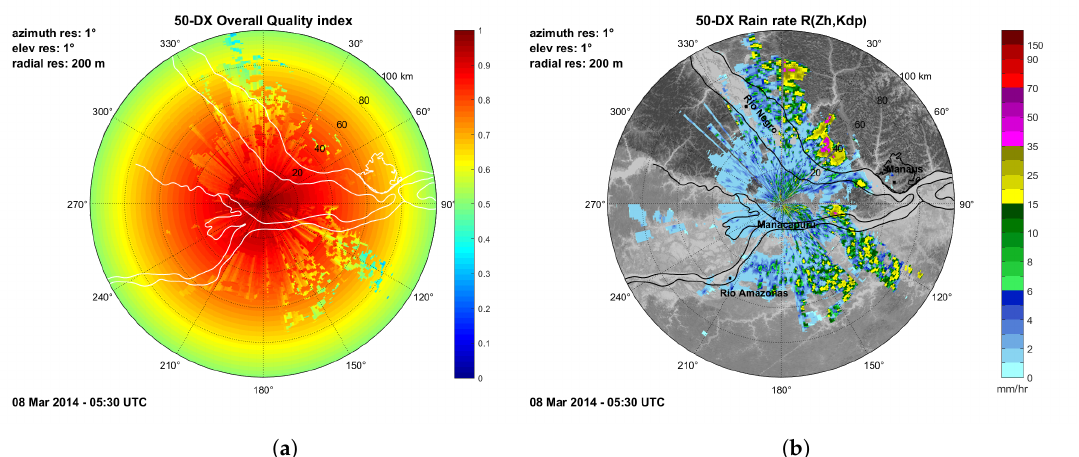
Figure 12. ( a ) Overall radar quality index and ( b ) Rain rate from radar on 8 March 2014 at 05:30 UTC.